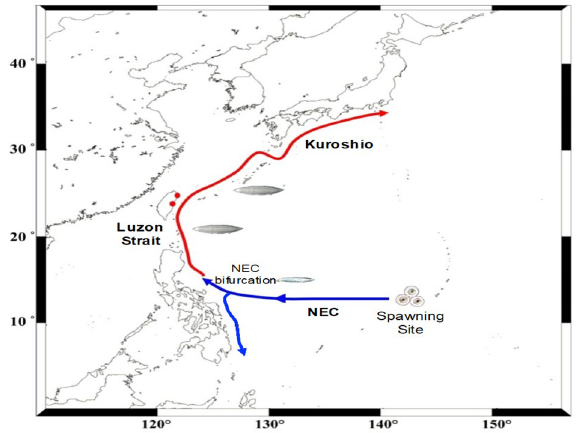
Figure 1. Map showing the spawning site and transport route of the eel larvae to Taiwan and Japan. Red dots indicate the sampling sites of the Japanese glass eel (Yilan and